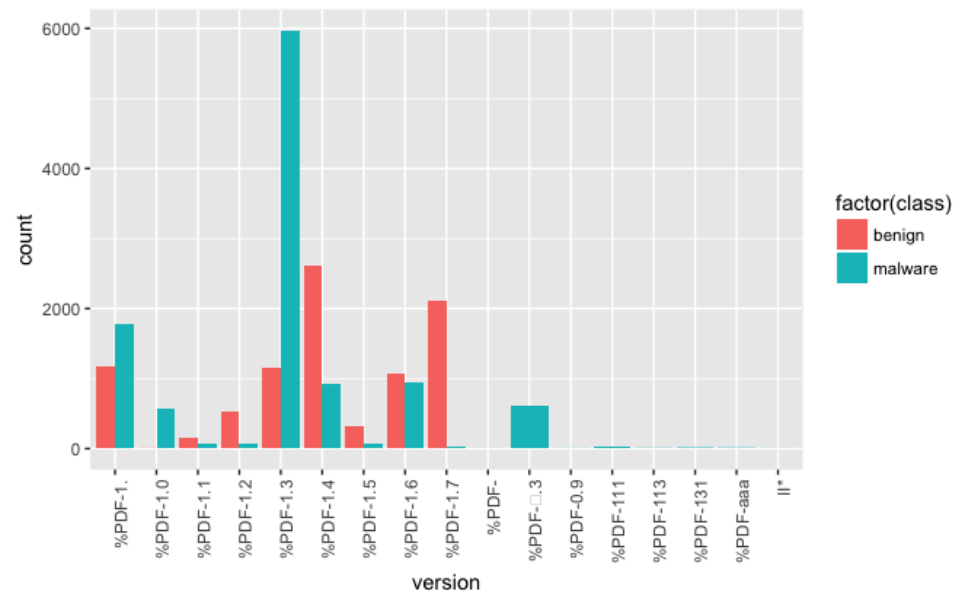
Figure 11. The numbers of usage of PDF versions.